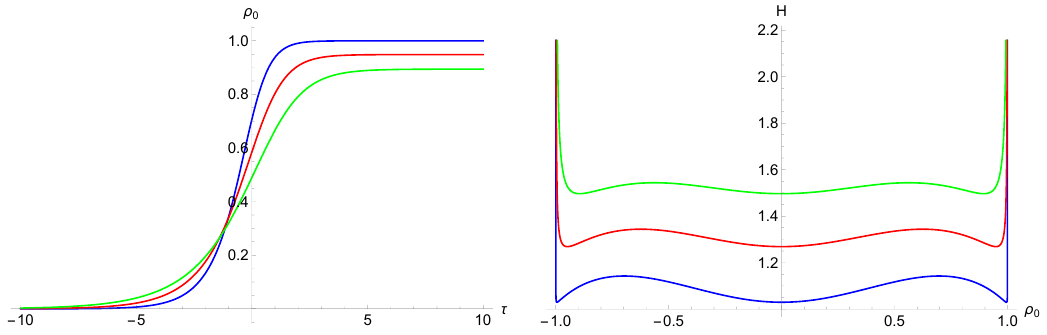
Figure 6 . Plot of the relation between ∆ and J 1 as depicted in equation (3.11). The tunnelling from the point to the giant graviton occurs only when the pair ( J the red line the point graviton is energetically favored and the tunnelling should be in the opposite direction.